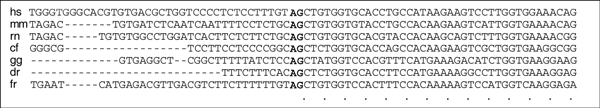
Alignment for a coding splice acceptor site. The figure shows the central part of a typical alignment window used by the classifier component of DOGFISH. Codon boundaries on the exon side of the splice site are indicated with dots. This site has an alignment with all species except frog: hs; Homo sapiens: mm; Mus musculus: rn; Rattus norvegicus: cf; Canis familiaris: gg; Gallus gallus: dr; Danio rerio: fr; Fugu rubripes. The AG dinucleotide for the acceptor site itself is shown in bold.